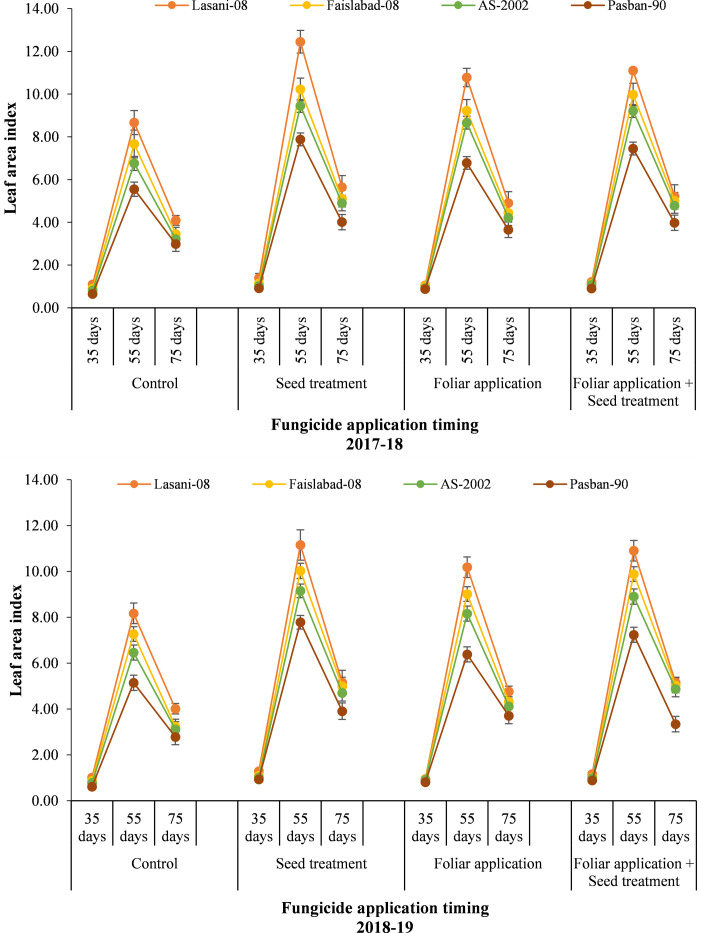
The influence of different fungicide application timings on leaf area index of wheat cultivars with varying tolerance to Karnal bunt disease.